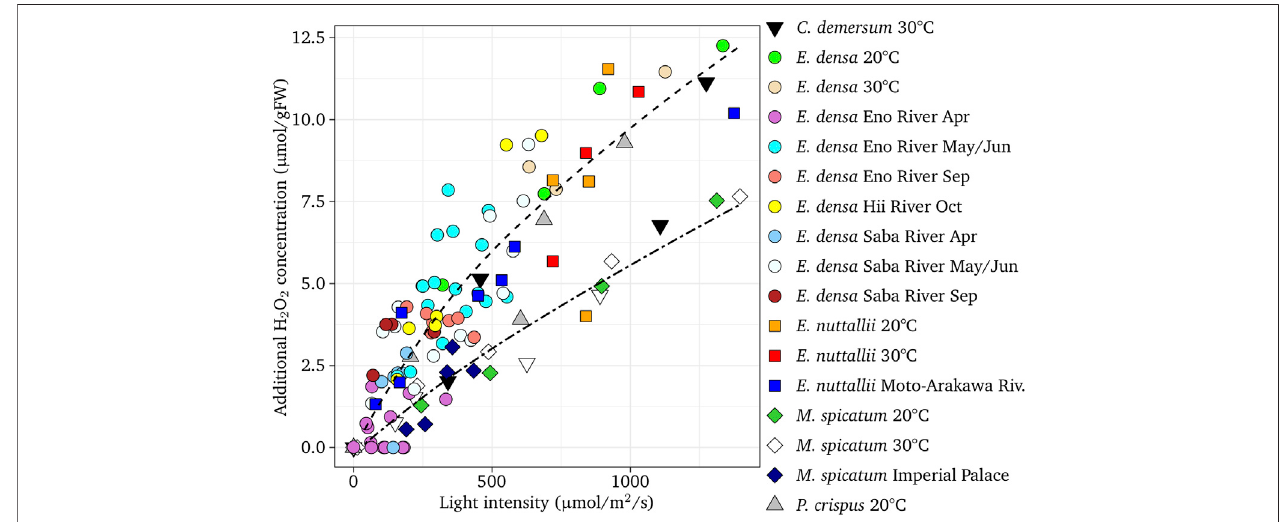
FIGURE 3 | Additional H 2 O 2 concentration of light-exposed tissues with respect to dark-adapted ones of different rivers and experiments as a function of the light intensity for different species. The regression curves, H 2 O 2 (cid:2) [light intensity − 40] 2/3 /10 (upper dotted curve) and H 2 O 2 (cid:2) [light intensity − 40] 5/6 /55 (lower dotted curve) are presented. Field samples of E. densa (Asaeda et al., 2020) are shown for comparison.